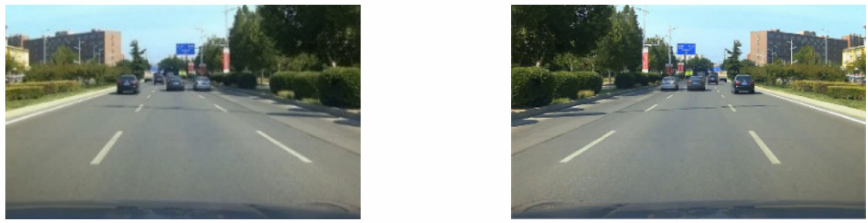
Figure 13. The random horizontal flipping.